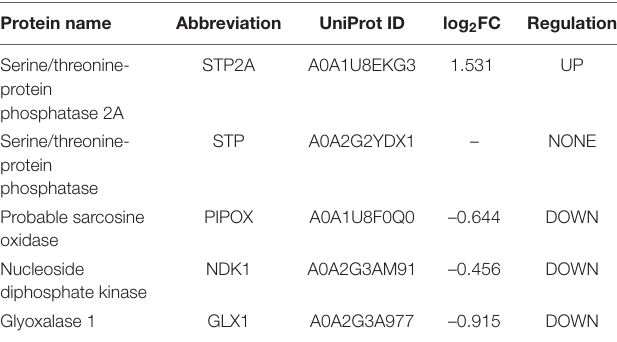
TABLE 2 | Peroxisomal matrix protein lacking PTS which are differentially expressed during sweet pepper fruit ripening.